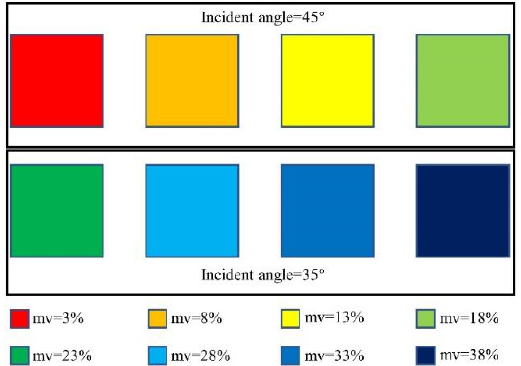
Figure 3. The generated simulated data’s ground truth.